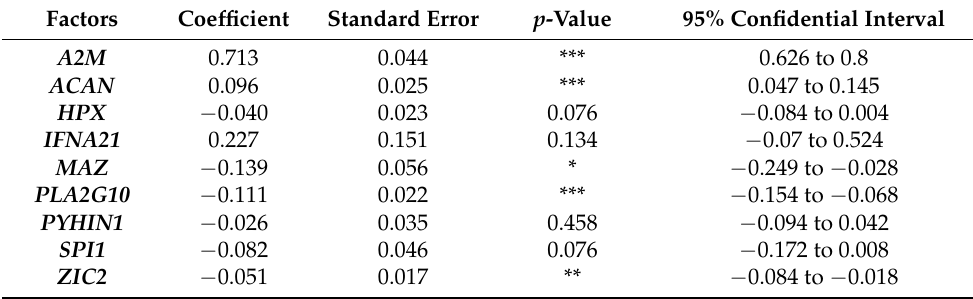
Table A1. Multiple linear regression analysis of ADAMTS1 in